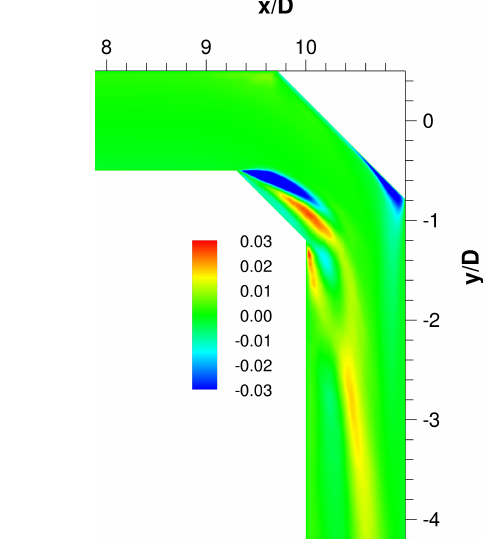
Figure 15. Time-averaged dimensionless turbulent kinetic energy (cid:104) k (cid:105) / U 2 plane at z / D = 0. ( a ) Re L . ( b ) Re H .